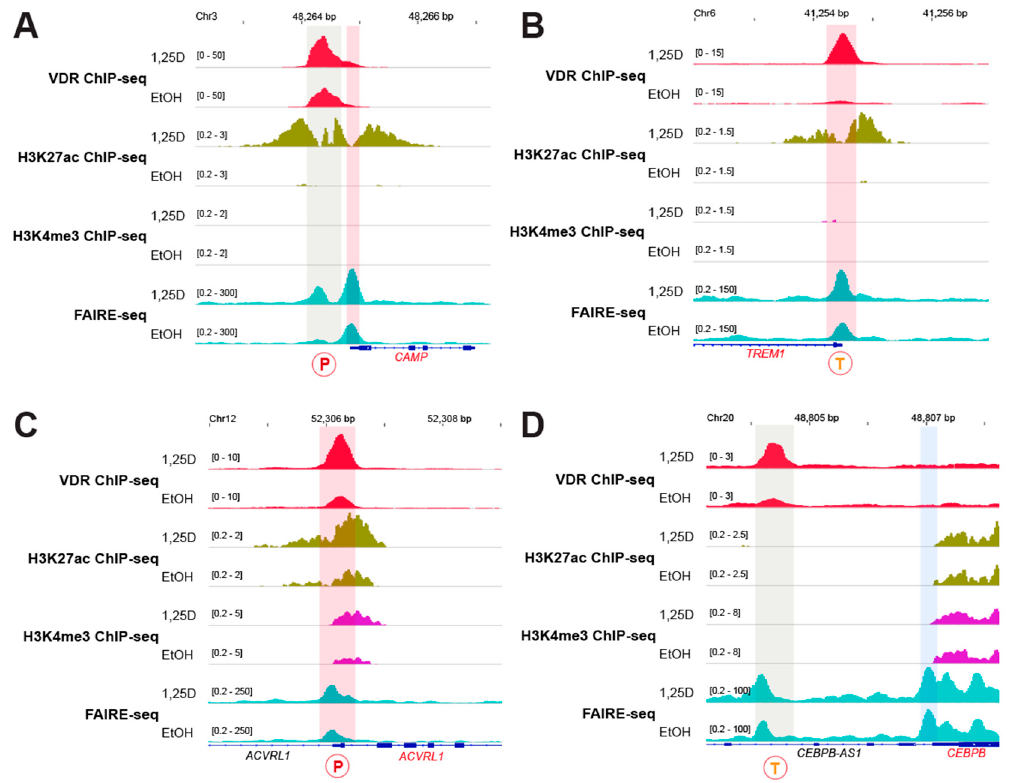
Figure 3. Vitamin D target genes regulated by single enhancers. The IGV browser was used to visualize VDR ChIP-seq results (red) obtained in THP-1 cells that had been treated for 24 h with 1,25(OH) 2 D 3 (1,25D) or solvent (EtOH) [28]. VDR-bound enhancers are shaded in grey, ligand-dependent TSS regions in red and non-ligand-dependent TSS regions in blue. The type of VDR binding sites at enhancers is indicated as persistent (P) or transient (T) [28]. These data are compared with ChIP-seq results obtained under the same conditions for histone markers of active chromatin (H3K27ac, green) [35] and active TSS regions (H3K4me3, purple) [35] as well as with FAIRE-seq data (turquoise) [29]. The peak tracks display merged data from the three biological repeats. Gene structures are shown in blue and the vitamin D target genes CAMP ( A ), TREM1 ( B ), ACVRL1 ( C ) and CEBPB ( D ) are highlighted in red.